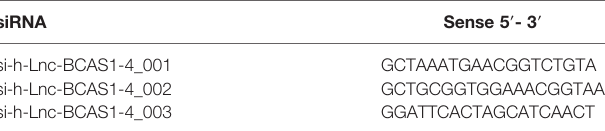
TABLE 2 | Target sequences of siRNA.